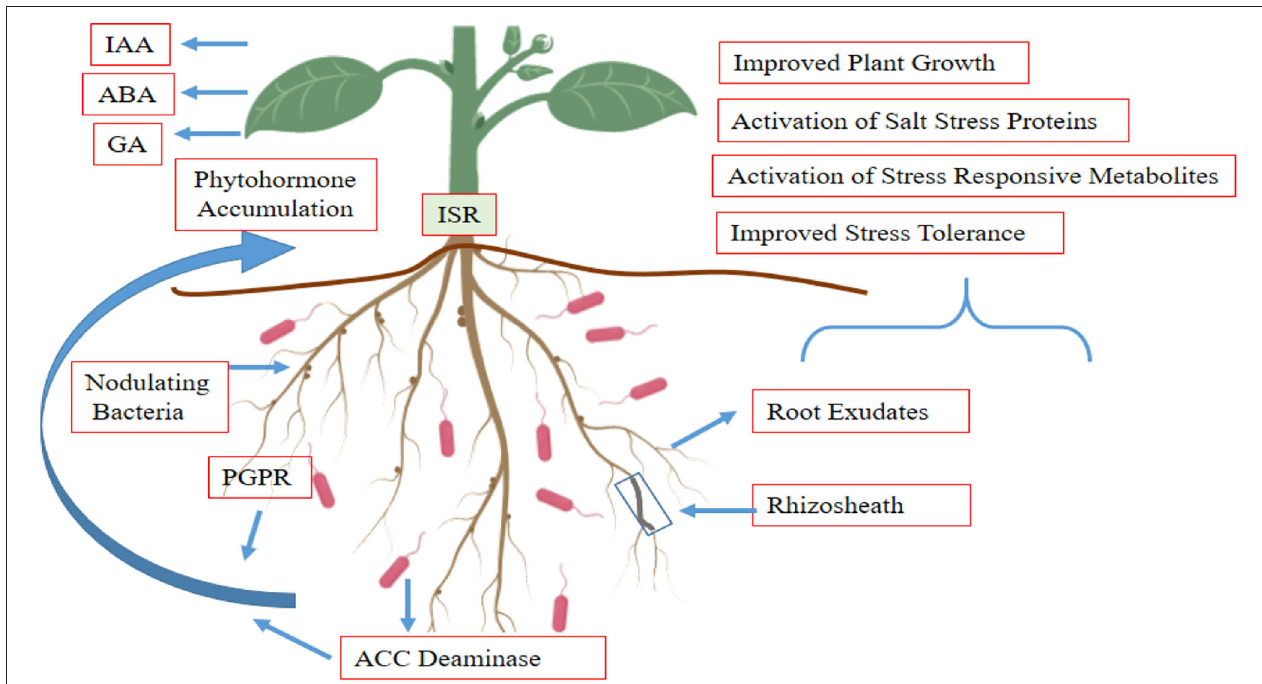
FIGURE 5 | Interactive effects of PGPR and growth substances in maintaining growth under saline